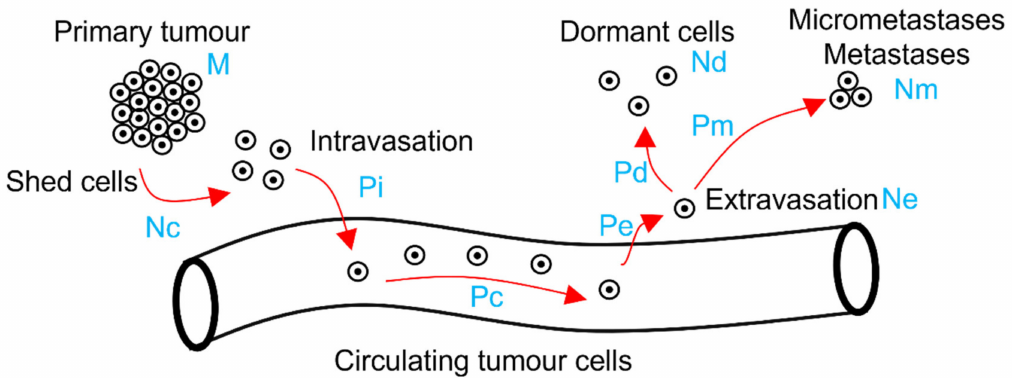
Figure 1. Illustration of the different steps of the metastatic cascade. Each step is represented by a red arrow. The blue text represents the associated parameters of the metastatic Drake